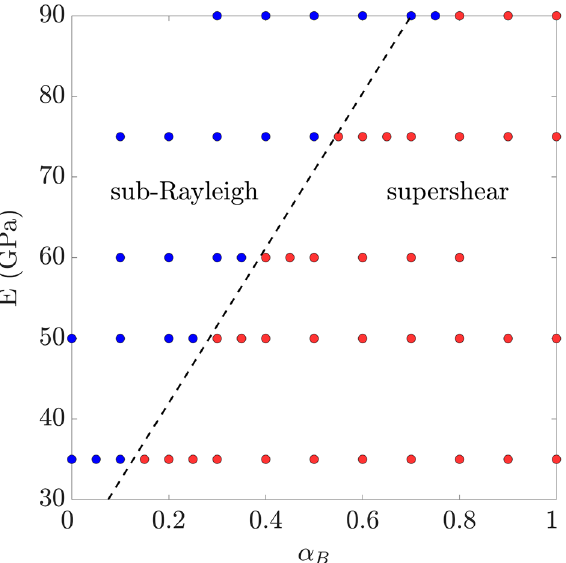
Figure 5. Phase diagram of sub-Rayleigh and supershear in the E - α B space, using the data shown in Fig. 4. Red dots are supershear cases, and blue dots are sub-Rayleigh ones. We also plot a tentative phase boundary (dashed black line).